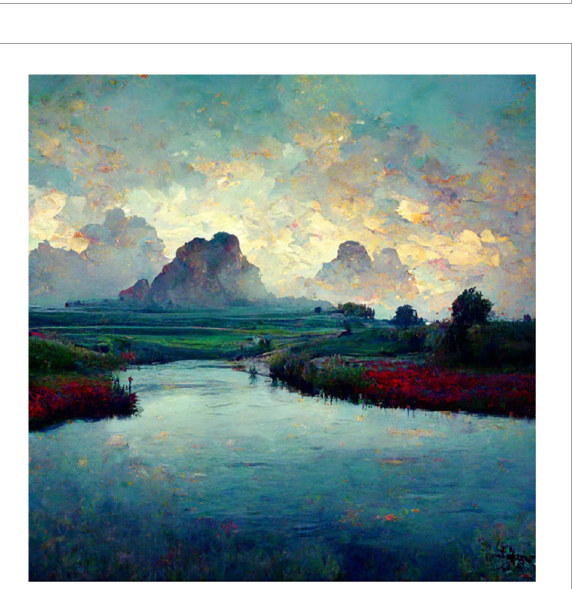
FIGURE8 Midjourney generated image to the prompt “a